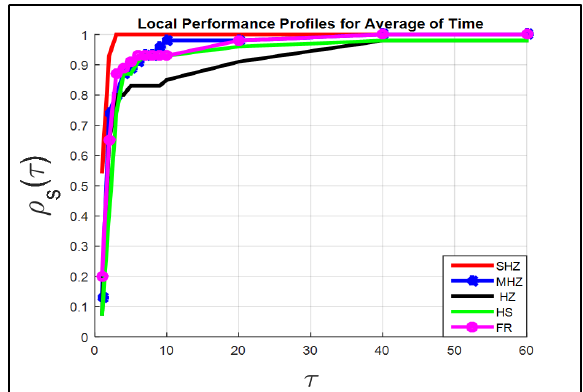
Figure 3. Plotting the results of the term time.a “CPU” for 5 algorithms.